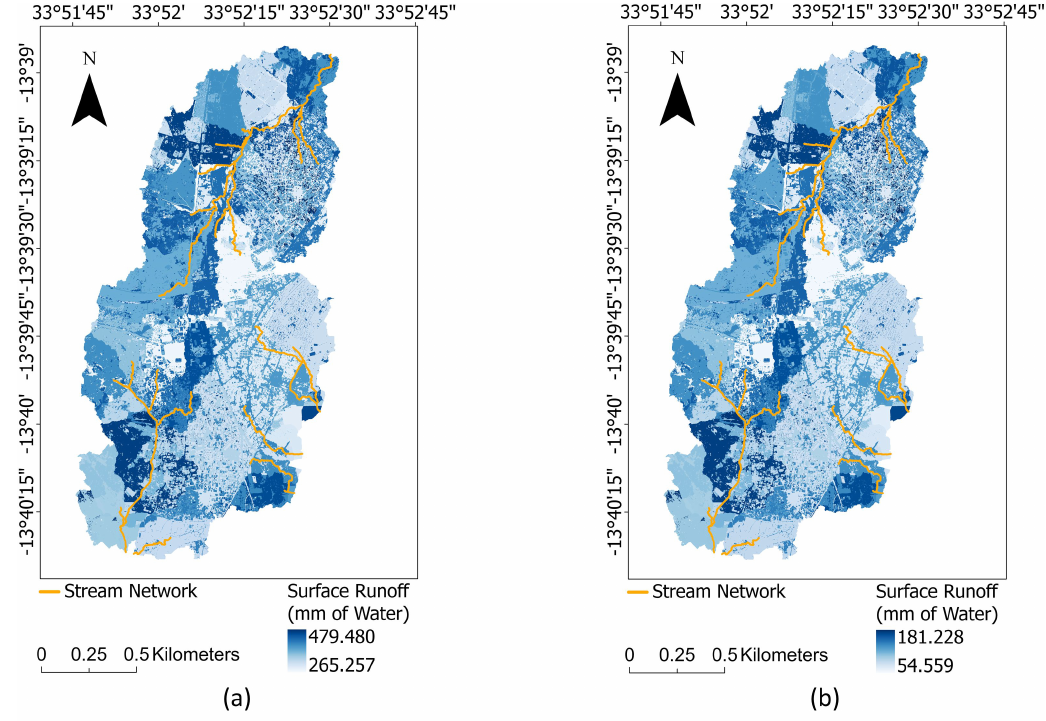
Figure 13. ( a ) Millimeters of water surface runoff accumulated in January 2013; ( b ) Millimeters of water surface runoff for a 10% exceedance